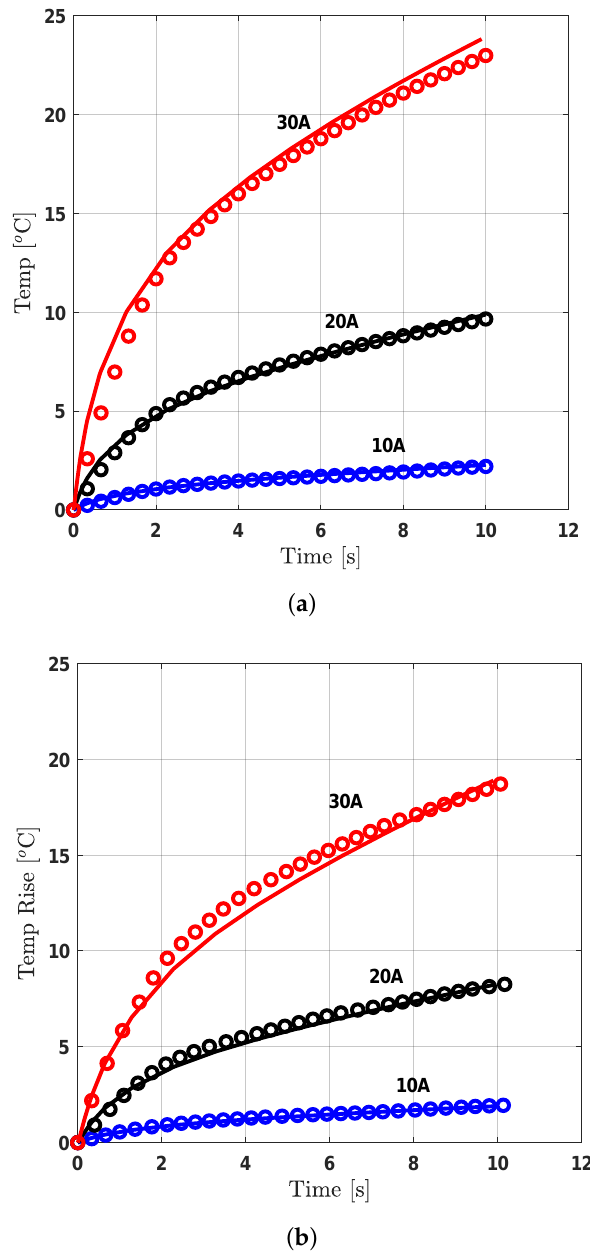
Figure 9. Measured (o) and predicted (-) temperature rise comparison for different current supplies. ( a ) Sample 1 with fault width of 2.2 mm. ( b ) Sample 2 with fault width of 3.0